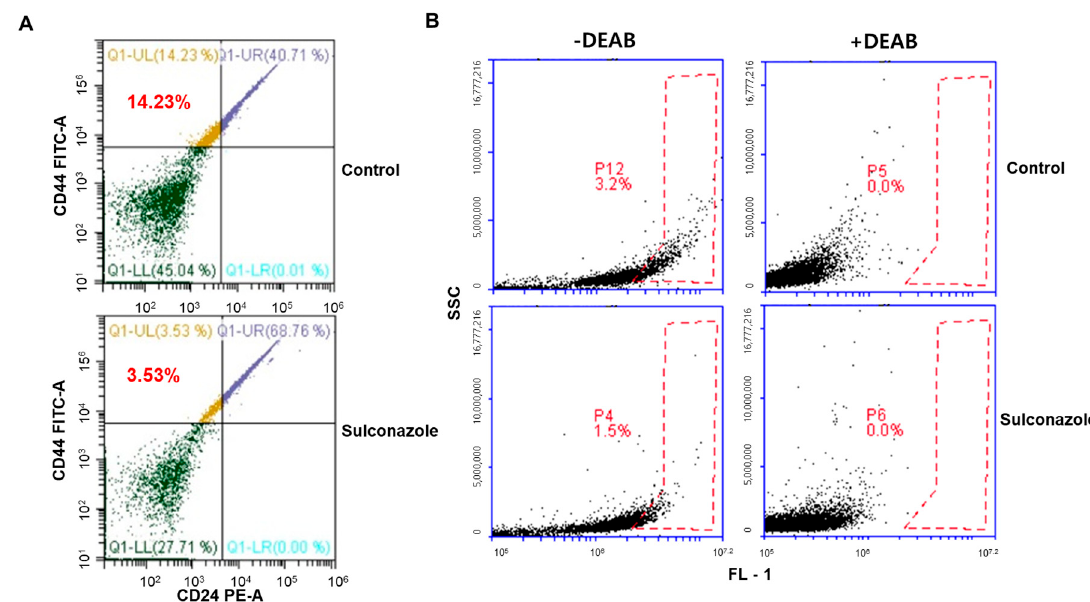
Figure 4. Effect of sulconazole on CD44 + /CD24 − -and ALDH-positive cell populations. ( A ) The CD44 + / CD24 − cell population treated with sulconazole (20 µ M) was assayed by flow cytometry. For FACS analysis, 10,000 cells were assayed. Gating was based on binding of the control antibody (Red cross). ( B ) ALDH-positive cells were detected by using an ALDEFLUOR kit. A representative flow cytometry dot plot is shown. The right panel indicates ALDH-positive cells treated with the ALDH inhibitor DEAB (7.5 µ M), and the left panel shows ALDH-positive cells without DEAB treatment. The ALDH-positive population was gated in a box (red dot line